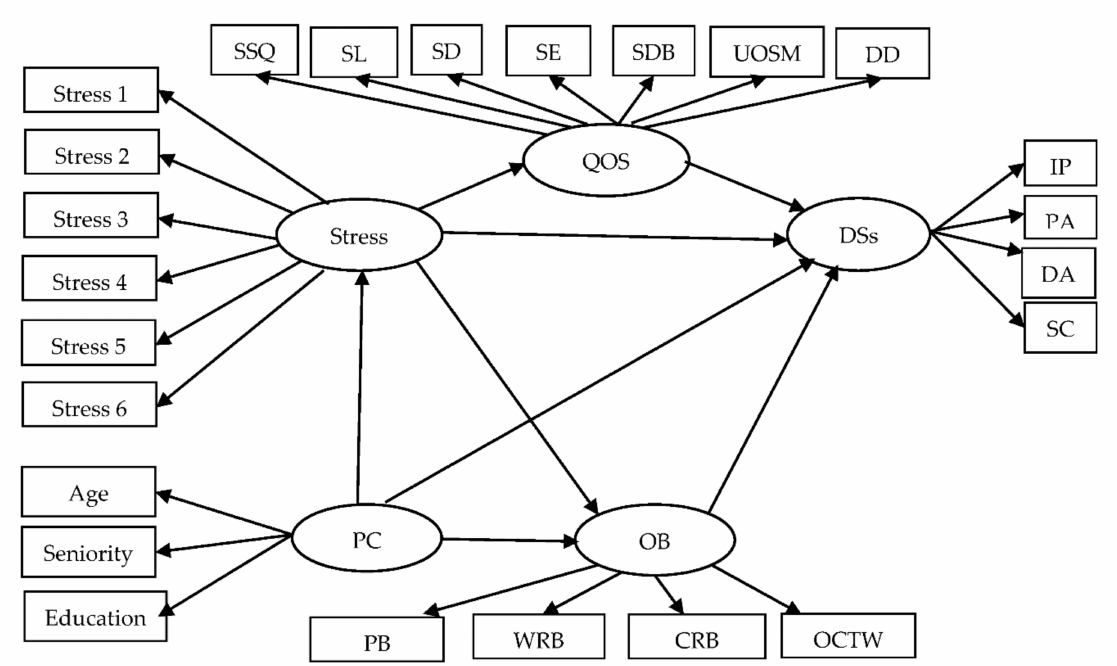
Figure 1. Conceptual framework of hypothesized model. Note. Personal characteristics = PC; quality of sleep = QOS; depressive symptoms = DSs; occupational burnout = OB; subjective sleep quality = SSQ; Sleep latency = SL; sleep duration = SD; Sleep efficiency = SE; sleep disturbance = SDB; use of sleeping medication = UOSM; Daytime dysfunction = DD; interpersonal problems = IP; positive affect = PA; depressed affect = DA; somatic complaints = SC; personal burnout = PB; work-related burnout = WRB; client-related burnout = CRB; over-commitment to work = OCTW; = latent variable; = measured variable; → = unidirectional